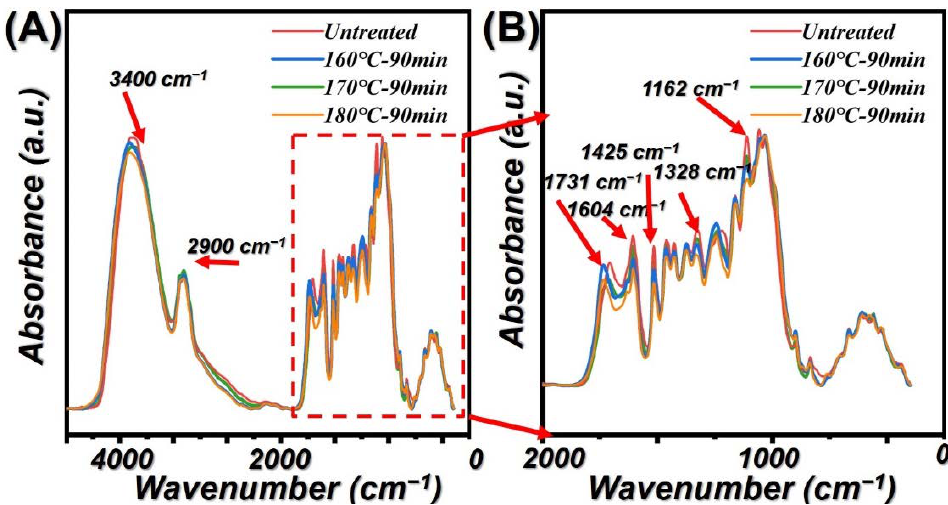
Figure 5. ( A ) Complete FTIR spectra for bamboo samples. ( B ) Partial FTIR curves of the bamboo samples different temperature and same time. samples different temperature and same